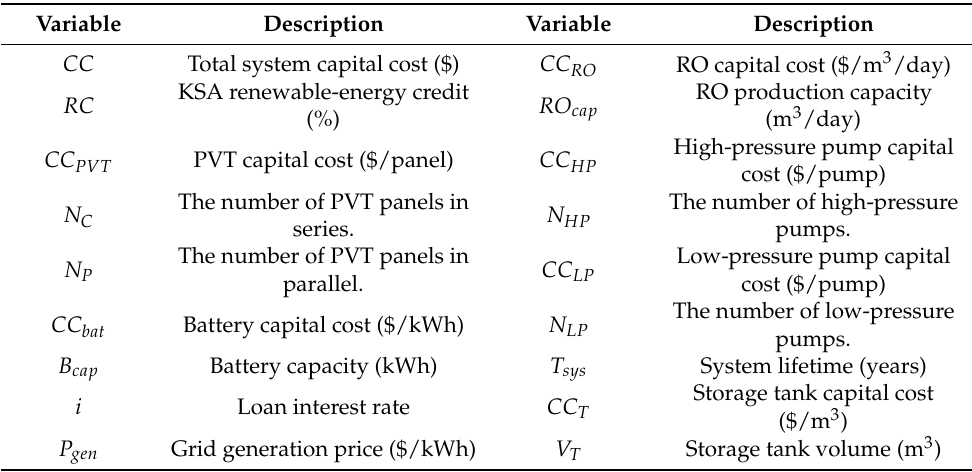
Table 1. Variables used for calculating annual system